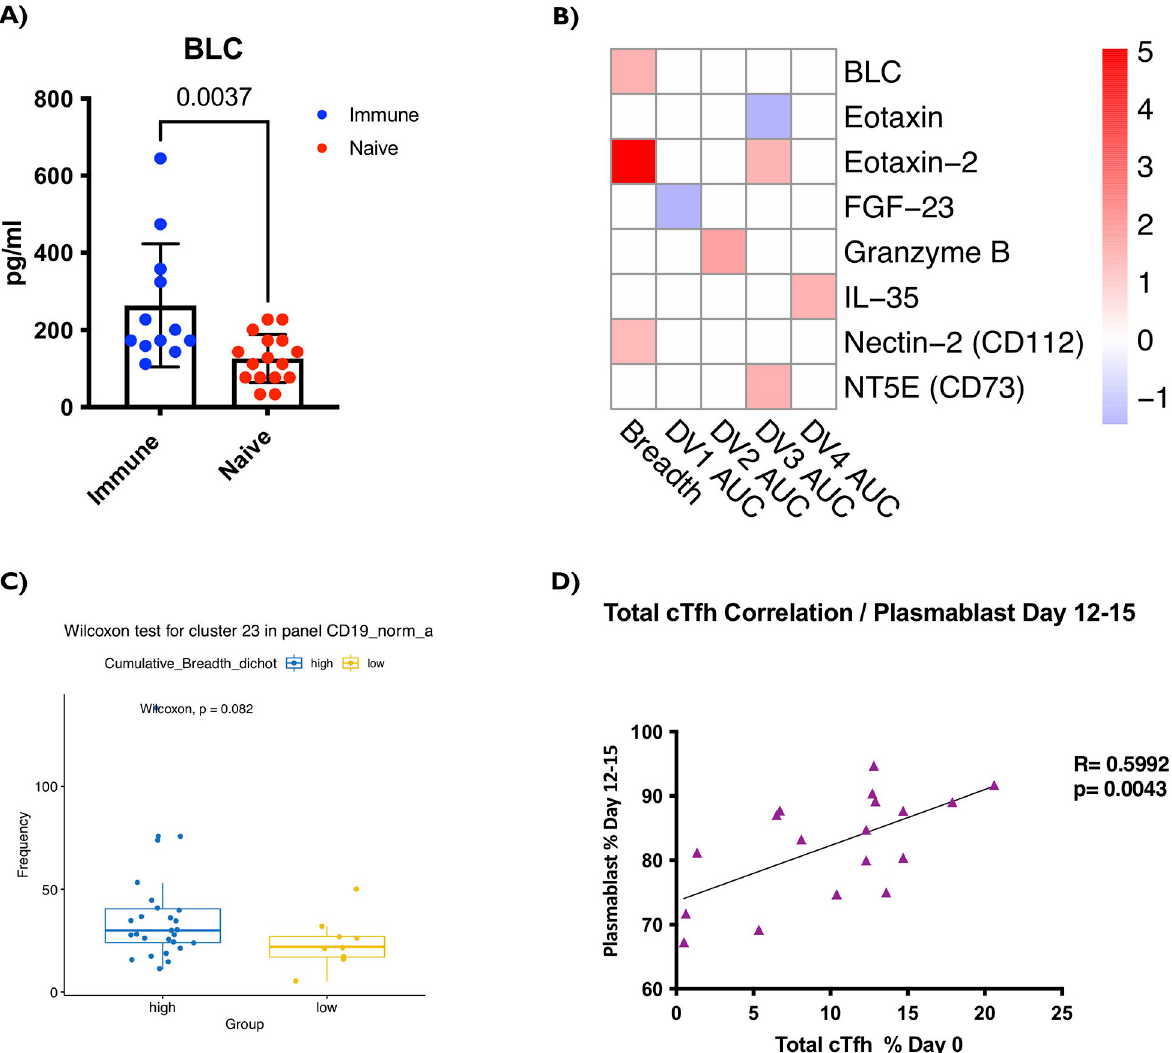
Fig 5. Higher CXCL13/BLC expression levels at pre-vaccination are associated with the breadth of the vaccine response. (A) Y axis shows CXCL13/BLC levels at pre-vaccination/baseline in pg/ml. Unpaired non-parametric Mann Whitney test, 95% confidence was calculated. (B) Heatmap of cytokines and chemokines are shown that are significantly correlated with neutralizing antibody titres (AUCp) as well as the breadth. The x axis of the heatmap has the neutralizing antibody titer (AUCp) for the four Dengue serotypes as well as the breadth. To the right of the heat map is the color gradient Signed log10 p-values (-log10 (p’) x sign of the Welch’s T-test or rho coefficient, respectively), which was used to show the strength of the association to each outcome. For the analytes in (A and B), neat Plasma samples were used. (Immune n = 12, Na ï ve n = 16.) (C) Representation of cluster 23 (Plasmablast) pre-vaccination/baseline subject samples were associated with breadth of the response post vaccination. This is cluster 23 of the t-Distributed Stochastic Neighbor Embedding (tSNE) for B cell panel in S4.Fig (D) Total cTfh frequency (CD3+ CD4 + CD45RA- CXCR5+) correlation day 0 (pre-vaccination) with plasmablast frequency Day 12–15 (post-vaccination) (CD19 +CD10-IgM-IgD-CD20-CD21-CD38+CD27+Ki67+). Pre-vaccination/baseline subjects PBMCs and optimized B cell panel for ex-vivo staining was utilized. 1 million cells per panel were stained. (Na ï ve n = 44, Immune n = 14). Post-vaccination/baseline subjects PBMCs and optimized B cell panel for ex-vivo staining was utilized. 1 million cells per panel were stained. (Na ï ve n = 12, Immune n = 6). Before vaccination, seropositive subjects with existing antibodies to any of the four Dengue virus serotypes due to prior infection before were referred to as (“Immune”) or seronegative subjects with no existing antibodies to any of the four Dengue virus serotypes were referred to as (“Na ï ve”). Paired non-parametric Wilcoxon test, 95% confidence was calculated for (C). Non-parametric Spearman Correlation (R = rho) with 95% confidence Interval was calculated for (D). Nominal p-values p < 0.05 were considered statistically significant. � p < 0.05, �� p < 0.01 and ��� p < 0.001. ���� p < 0.0001. correlated negatively (p = 0.0113) (S8 Fig). We further observed that the majority of the B-cell subsets measured at day 0, including total CD19+ B-cells (S4A Fig), total class-switched B-cells characterized by CD19+CD10-IgM-IgD- expression (S4B Fig), and activated memory B-cells,